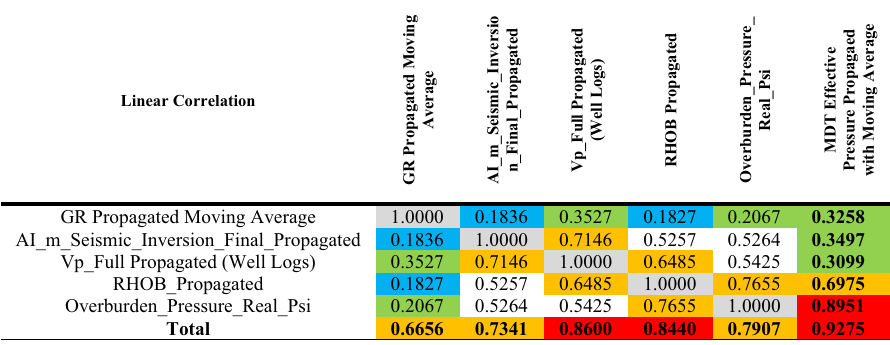
Table 3 Linear correlation of the principal component analysis (PCA) of the final effective pressure neural network model obtained